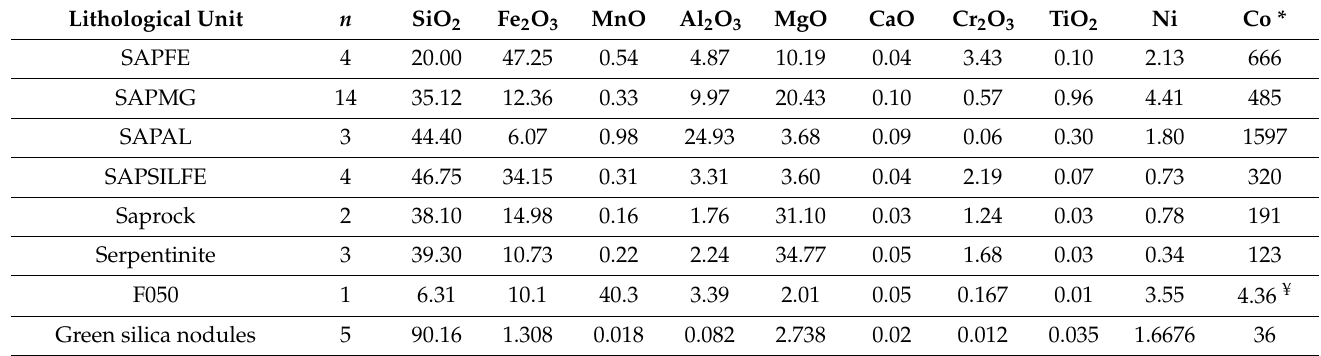
Table 4. Average bulk chemistries in wt% for the Piau í laterite lithological units as described in this study and some green silica nodules from the SAPSILFE unit. F050 is an aggregate of black mineral grains and coatings within the SAPSILFE unit directly associated with a white-green SAPAL layers (see Figure 4F). * Co is listed in ppm except for ¥ where the value for F050 is in